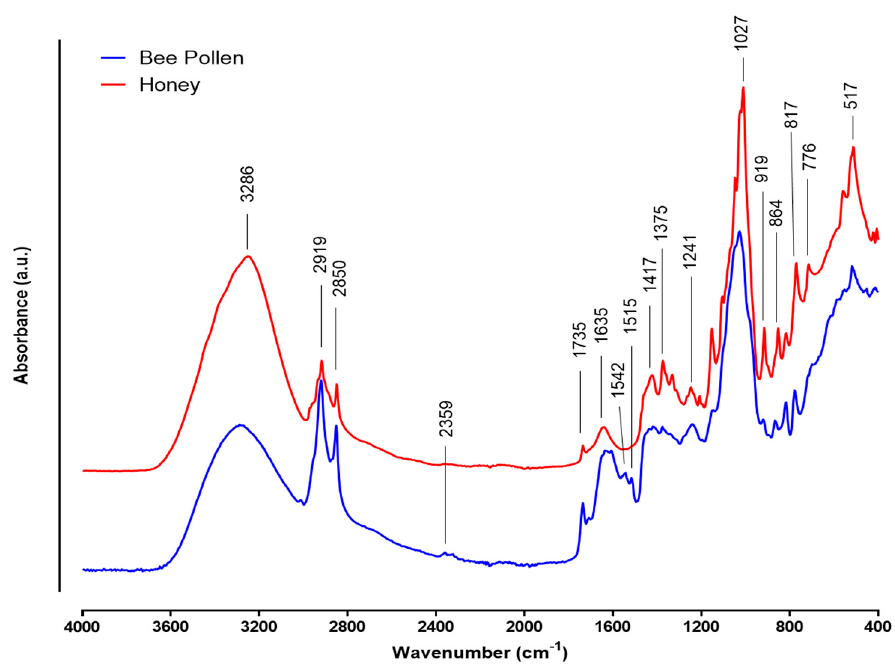
Figure 2. FTIR-ATR spectrum of honey and bee pollen.